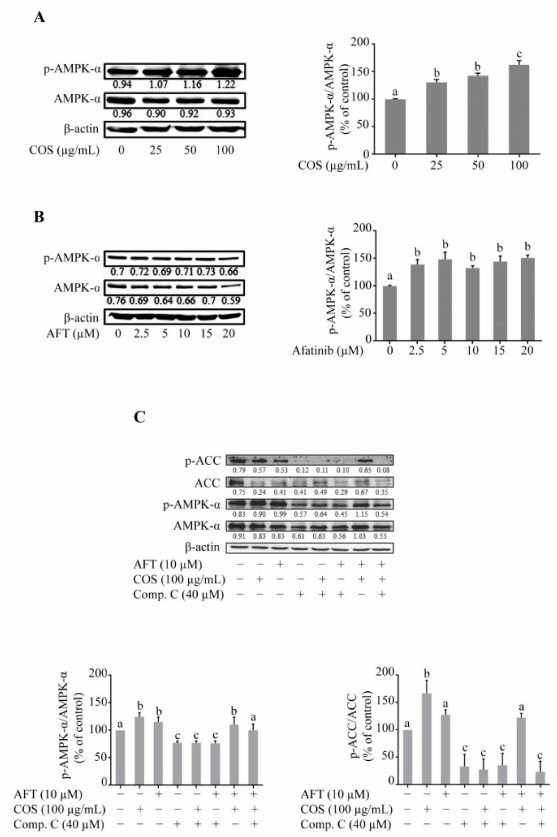
Figure 4. The effects of COS and afatinib on AMPK activation. T84 cells were treated with the indicated concentrations of COS ( A ), afatinib ( B ) or in combination ( C ) in the presence or absence of an AMPK inhibitor, Compound C (40 µ M), for 24 h before performing Western blot analysis. Data were analyzed as the ratio of p-AMPK- α /AMPK- α and p-ACC/ACC and expressed as % of control (vehicle-treated group), means ± SD ( n = 5; p < 0.05 one-way ANOVA). Columns that do not share the same superscript letters differ significantly ( p < 0.05, Tukey’s post hoc